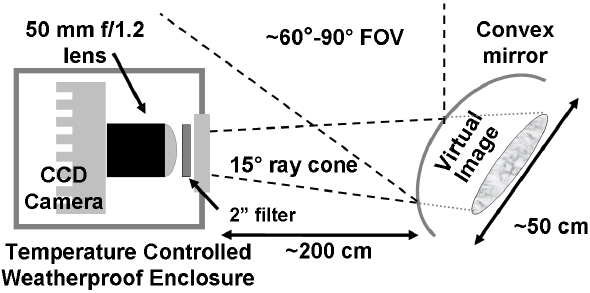
Fig. 8. Schematic of the HAARPOON remote automated imager design